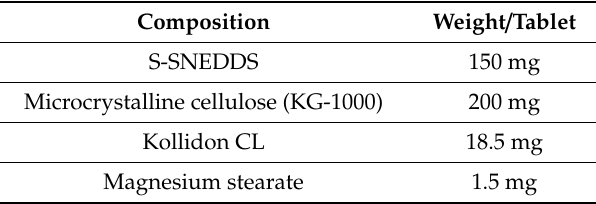
Table 2. Composition of the optimized tablet